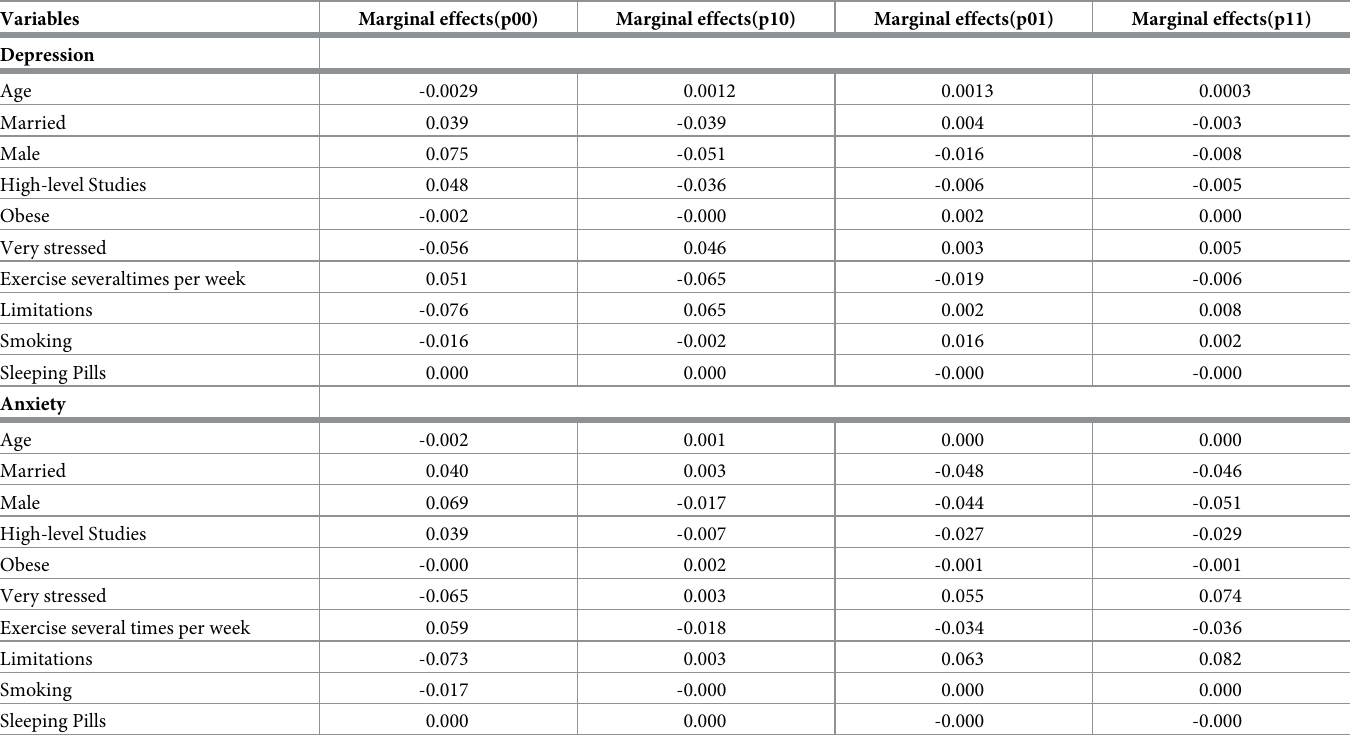
Table 6. Marginal